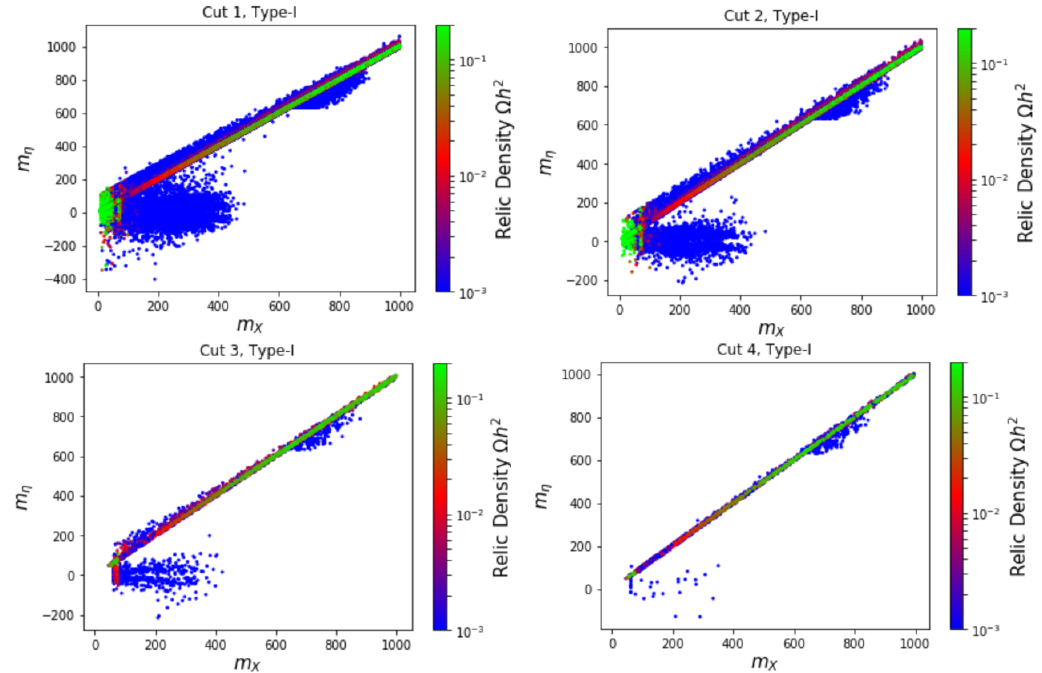
Figure 1 . Allowed points of parameter space that survived the succession of cuts. In Cut 1 (upper left) we applied unitarity, positivity and B physics constraints, in Cut 2 (upper right) shows points that survive after imposing EWPO and LEP constraints, in Cut 3 (lower left) the LHC constraints on the Higgs boson signal strengths and heavy Higgs searches limits were imposed as well as the upper bound on DM relic abundance are applied and (cid:12)nally in Cut 4 (lower right) the LUX and XENON1T experimental results on the spin independent cross section were implemented. In the vertical axis we took the square root of the absolute value of inert sector mass parameter m (cid:17) so that negative allowed values correspond to (cid:0) m 2 in the scalar (cid:17)